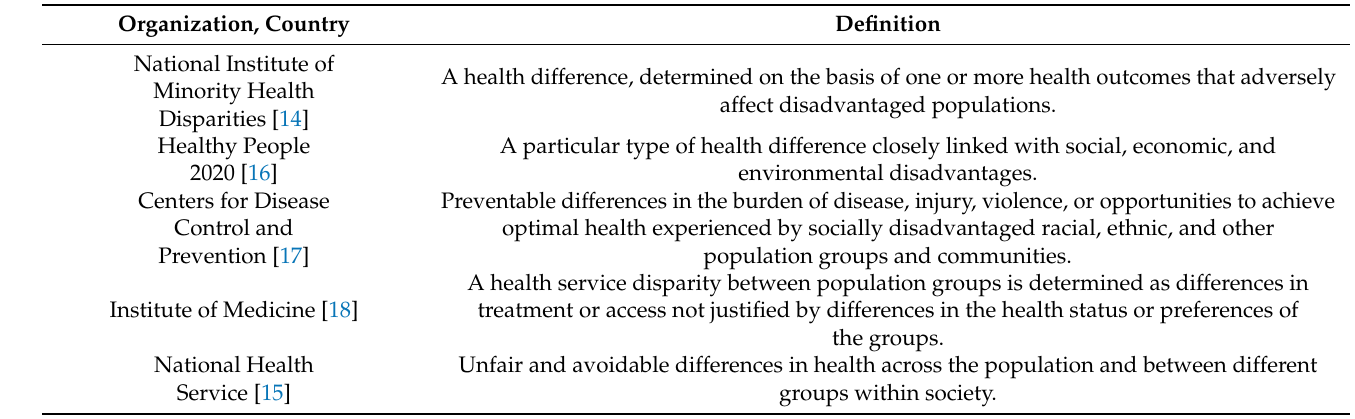
Table 1. Different definitions of health disparity and health